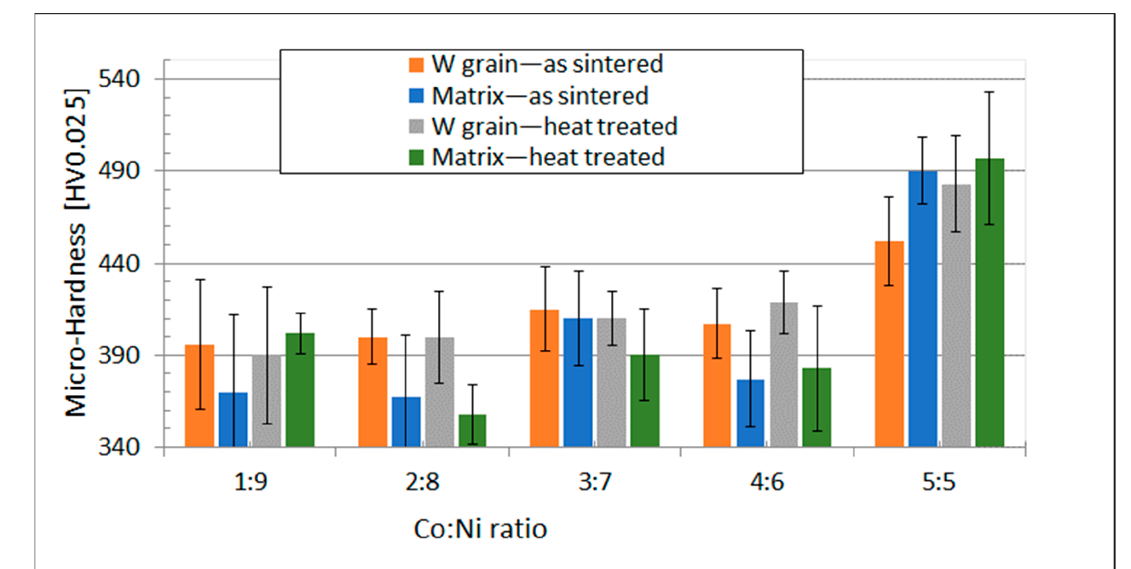
Figure 10. Change of hardness HV0.025 as function of the Co to Ni ratio.